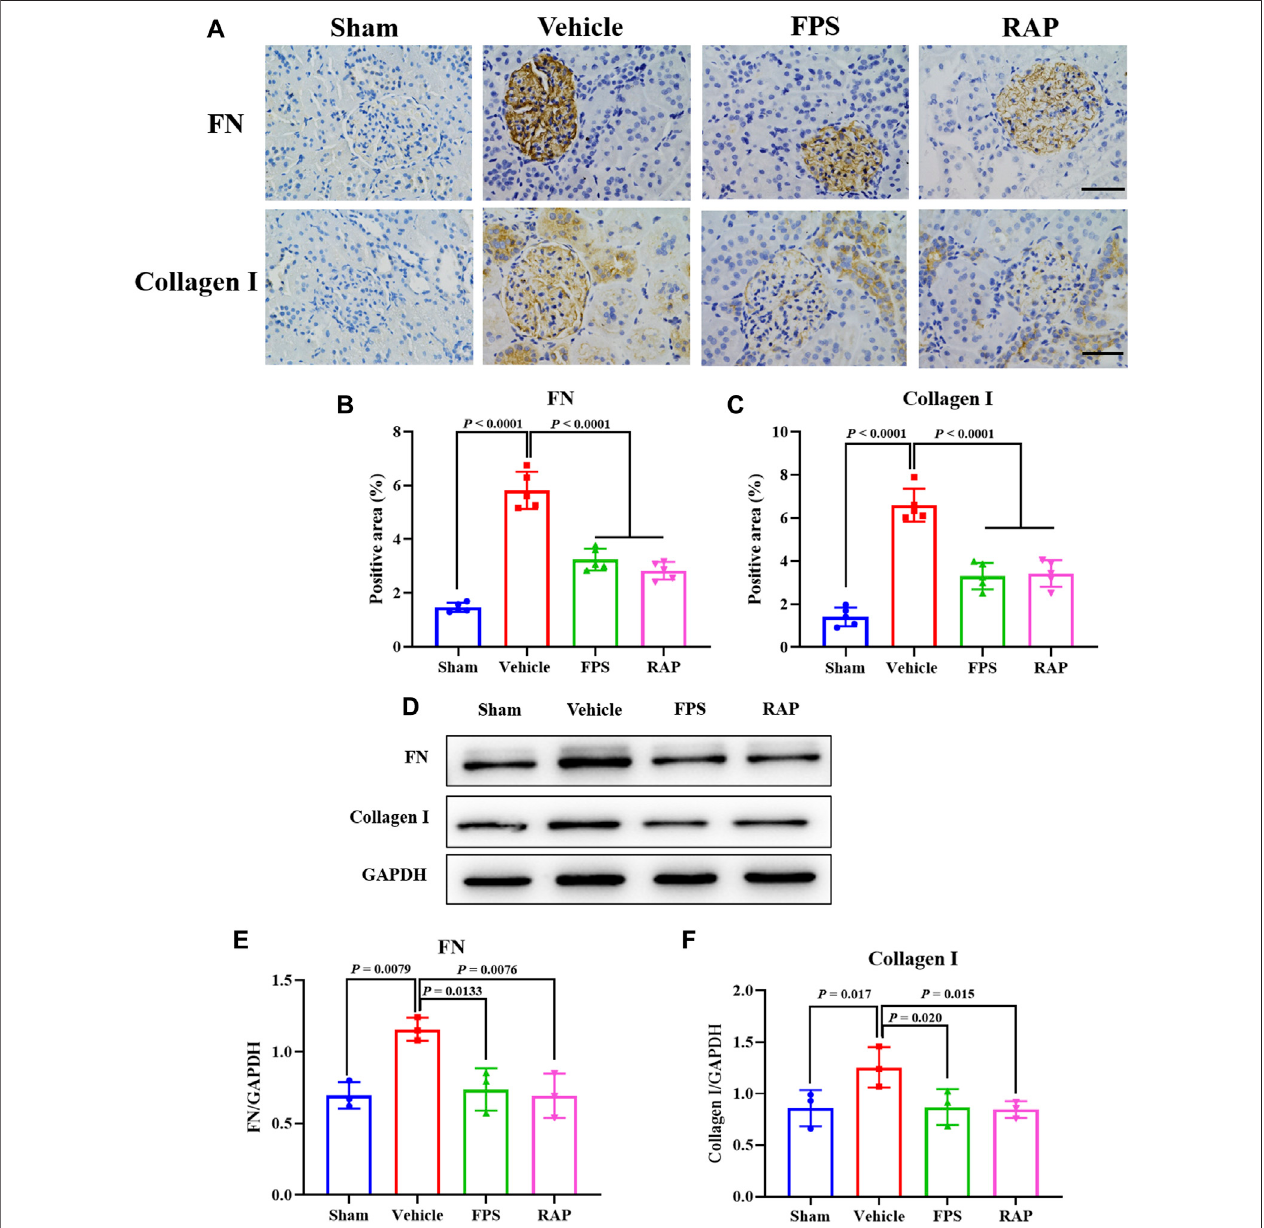
FIGURE2| EffectsofFPSand RAPontheexpressionlevels ofFNandcollagenI invivo . (A) TheimmunostainingofFNandcollagenIinglomeruli(×400).Scalebar = 50 μ m. (B,C) The positivearea of FN and collagenI in glomeruli. (D) The WB analysis ofFN and collagen I inthe diabetickidneys. (E,F) Therate of FN and collagen Ito GAPDH, respectively. The data are expressed as the mean ±